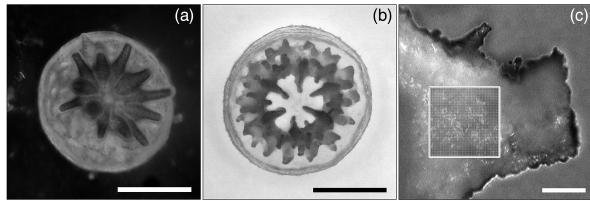
Figure 1. One-month-old living Acropora spicifera recruit (a) , a typical Acropora spicifera recruit skeleton with organic mate- rial removed (b) and crushed skeletal material showing a typical ∼ 60µm 2 scan area grid analyzed by Raman spectroscopy (c) . Scale